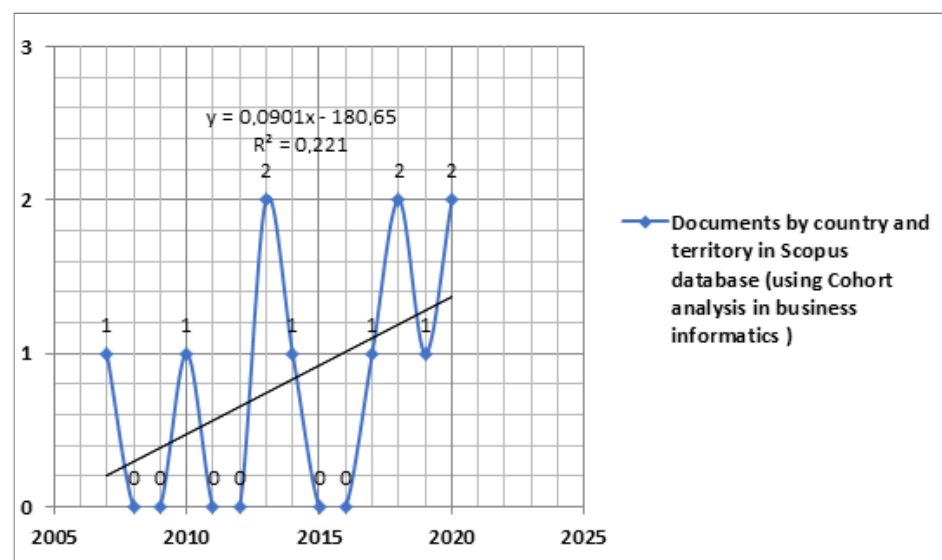
Figure 3. The search query for the scientific papers in the Scopus database.